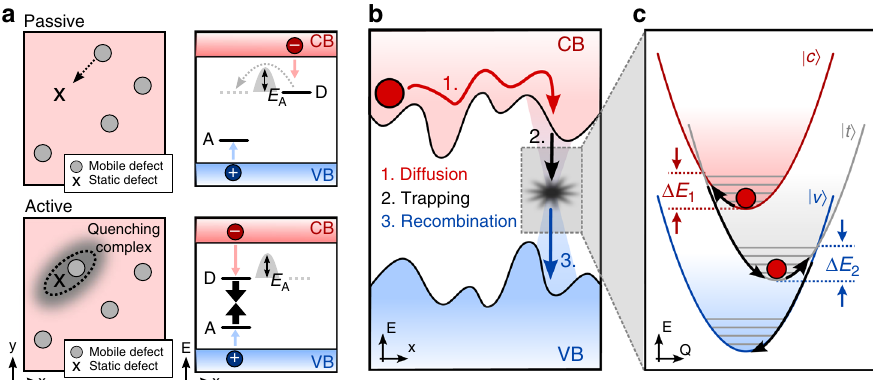
Fig. 7 Proposed switching and quenching mechanisms. The mechanism of switching in a is exempli fi ed for the formation of a donor-acceptor complex in real space (left) and an energy level diagram (right). CB denotes the conduction band, VB the valence band and D (A) the donor (acceptor) level inside the band gap. The system contains at least two types of defects and one of these defects is mobile. Both species on their own do not act as ef fi cient quenchers (see upper panels: Passive con fi guration), but when two defects of different kind get close, they form an active quencher with a high quenching ef fi ciency (lower panels). Panel b is a schematic of the non-radiative decay process in a semiconductor. It consists of diffusion (1), trapping (2) and recombination (3). Each of these steps could be thermally activated. Diffusion to the quenching site can be limited due to a disordered lattice potential. Energetic barriers for trapping and recombination arise due to reorganization of the nuclei of the local center, as illustrated in c . The system can be in three different electronic states and the corresponding potentials as functions of the nuclear coordinates of the center are shown: Excited state (state j c > = free electron in the conduction band, neutral center), intermediate state (trap state j t > = electron is trapped at the center) and ground state (state j v > = neutral center, no free charges). The energy barriers involved in charge capture ( Δ E 1 ) and recombination ( Δ E 2 ) depend on the coupling strength between the trap and the lattice vibrations and on the energetic position of the trap level inside the band gap. For ef fi cient non-radiative recombination both Δ E 1 and Δ E 2 should be as small as possible which means that the trap level should be close to the middle of the band